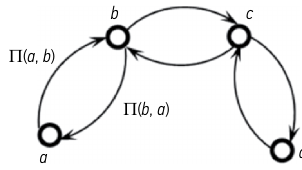
Fig. 1. Valued outranking